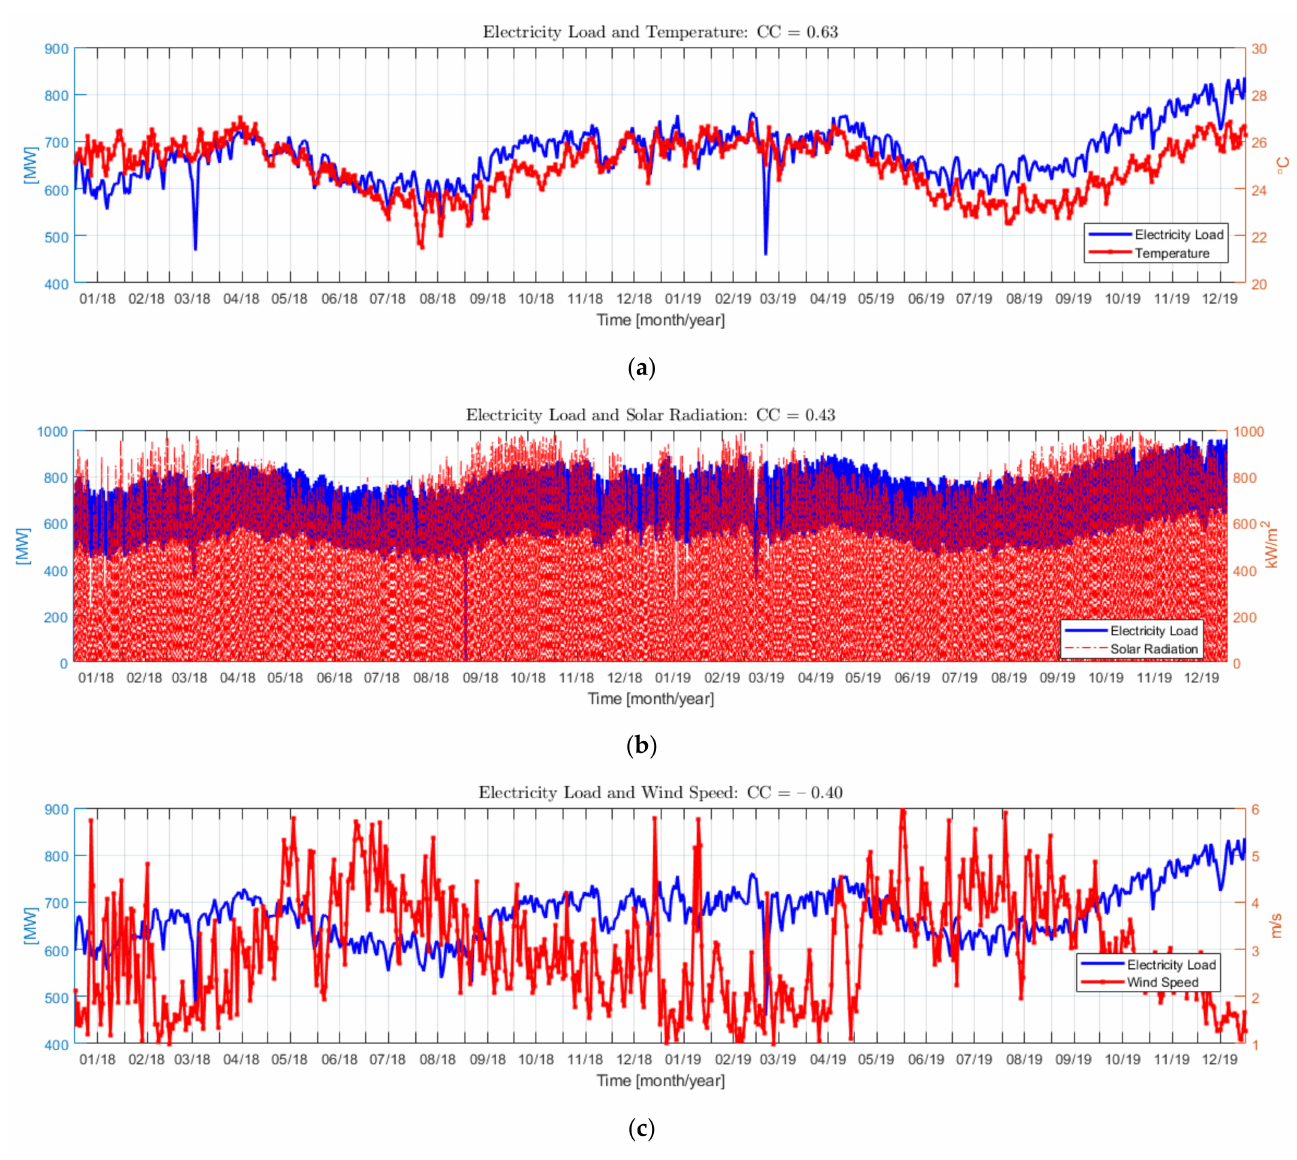
Figure 6. Plots of electricity load in Bali during 2019 in comparison with weather parameters; ( a ) temperature; ( b ) solar radiation; ( c ) wind speed. The magnitude of electricity load belongs to left y -axis, whereas the magnitude of weather parameters is in the right y